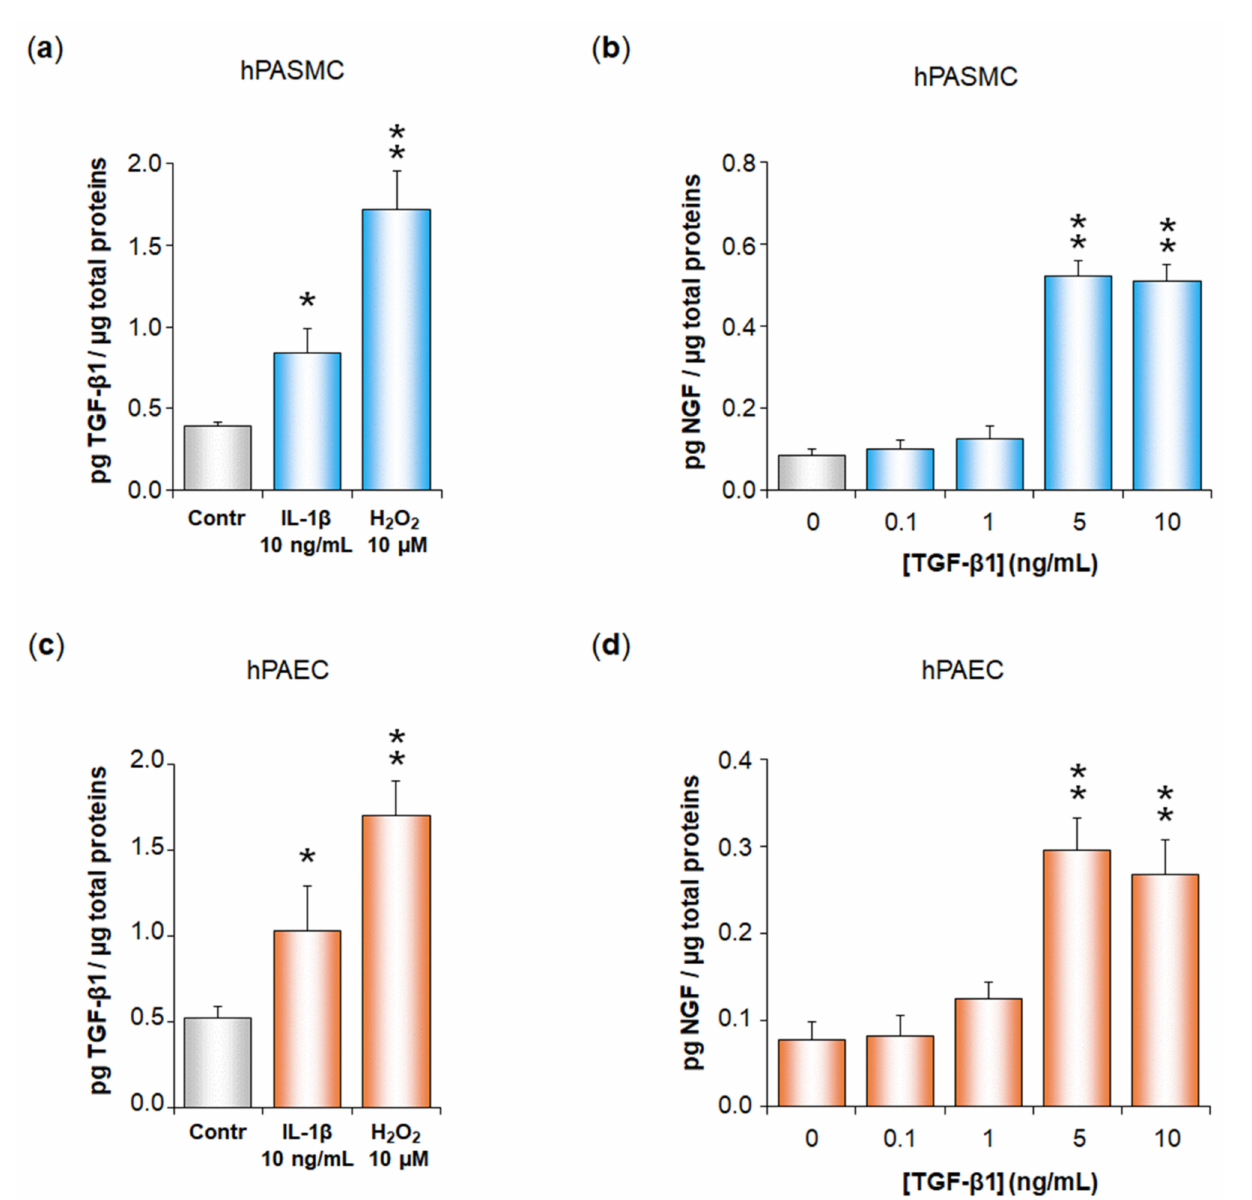
or p < 0.05, Figure 4a), or with anti-TGF- β 1 blocking antibodies ( p < 0.05, Figure 4b). Similar results were observed in hPAEC pre-treated either with the anti-TGF- β 1 siRNA ( p < 0.05, Figure 4c), or with anti-TGF- β 1 blocking antibodies ( p < 0.05, Figure 4d).